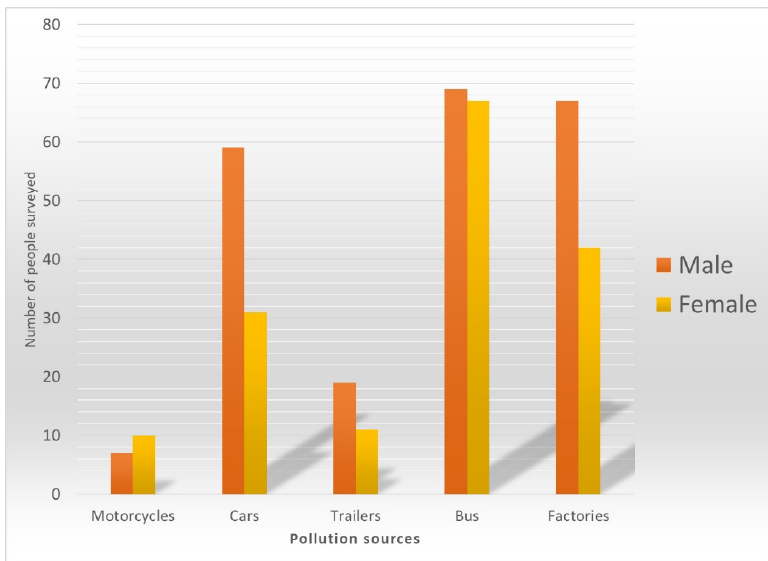
Figure 8. What do you think contaminates more (by gender)?